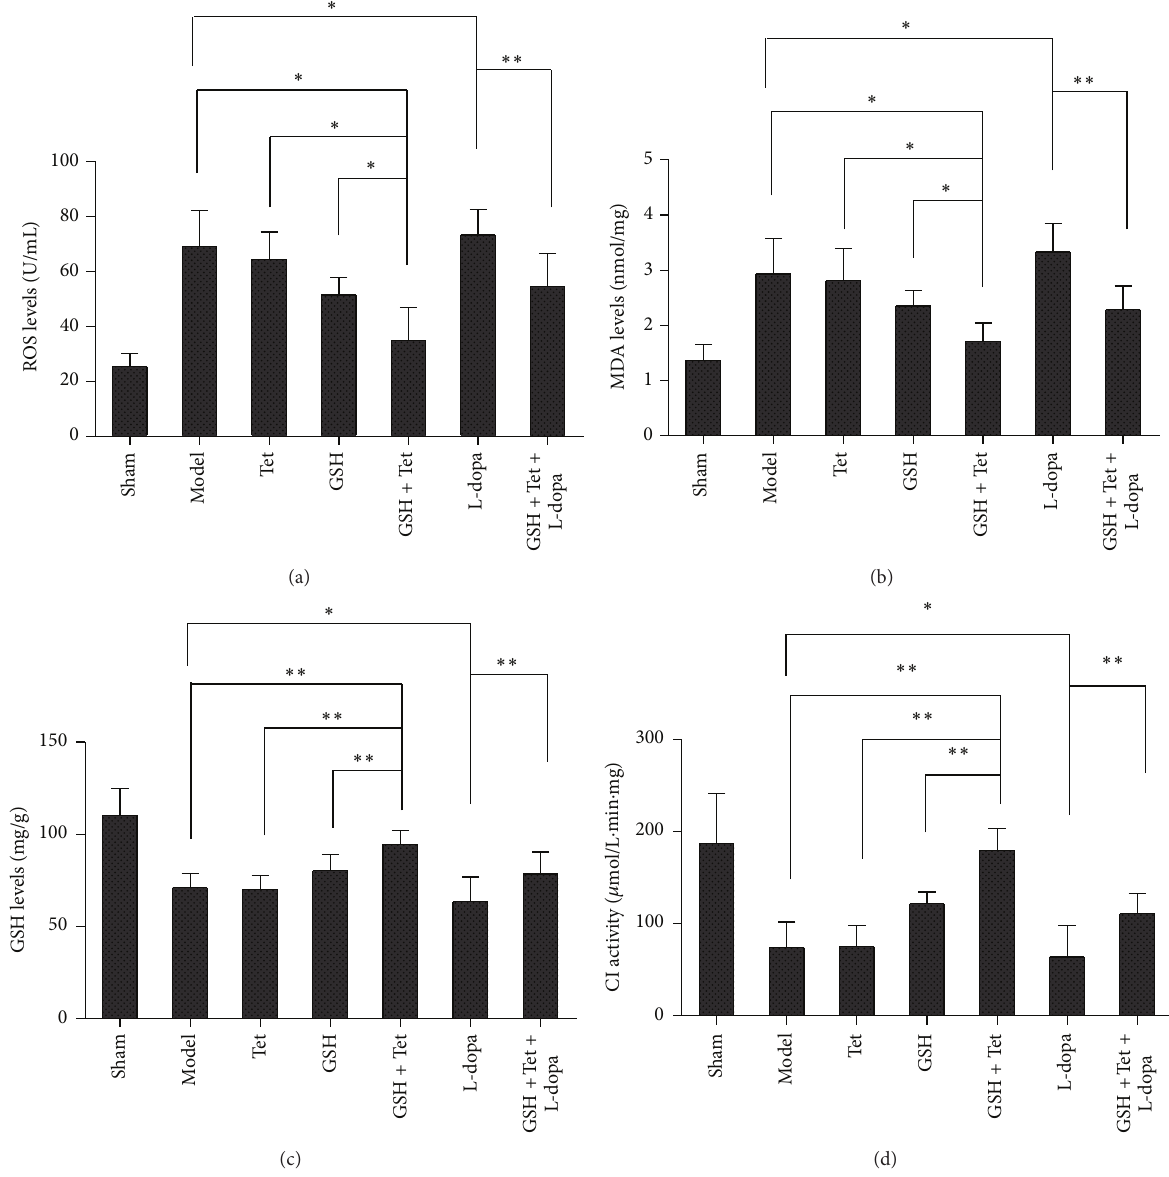
Figure 4: Changes in Reactive Oxygen Species (ROS) (a) and malondialdehyde (MDA) (b) in the striatum, as well as glutathione (GSH) (c) and Complex I (CI) activity (d) in the substantia nigra (SN). Bars represent mean ± standard deviation (SD) for six animals per group. ∗ 𝑝 < 0.05 , ∗∗ 𝑝 < 0.01 comparison among different groups after drug treatment.